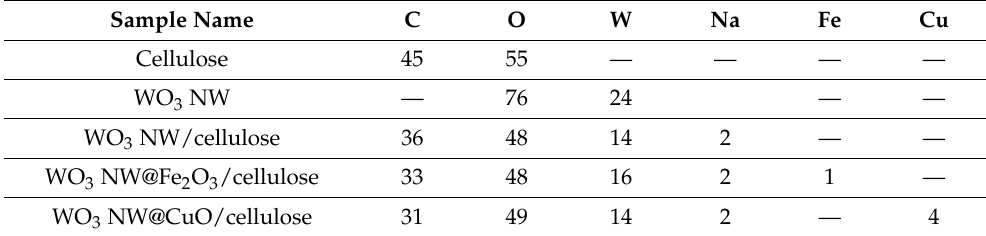
Table 1. Elemental (EDS) analysis of raw materials (cellulose and WO 3 NW) and the membranes.